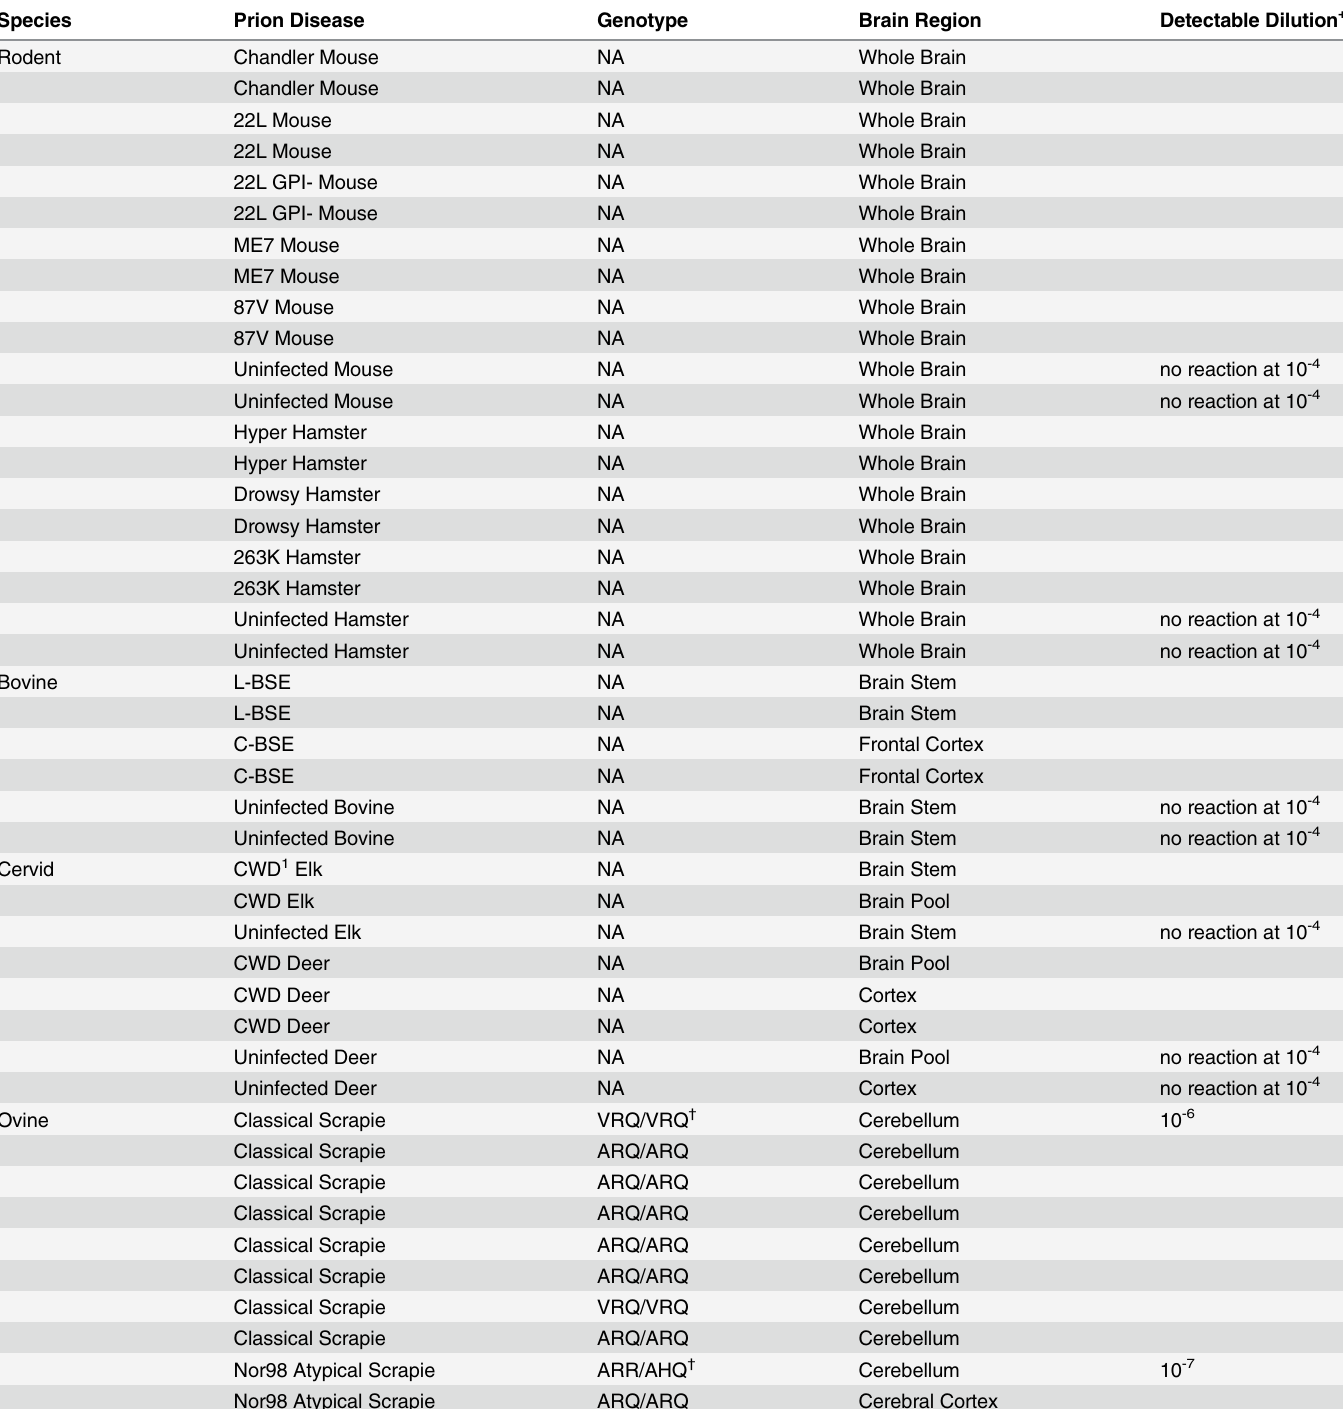
Table 2. Animal samples: prion disease, Prnp genotype and brain